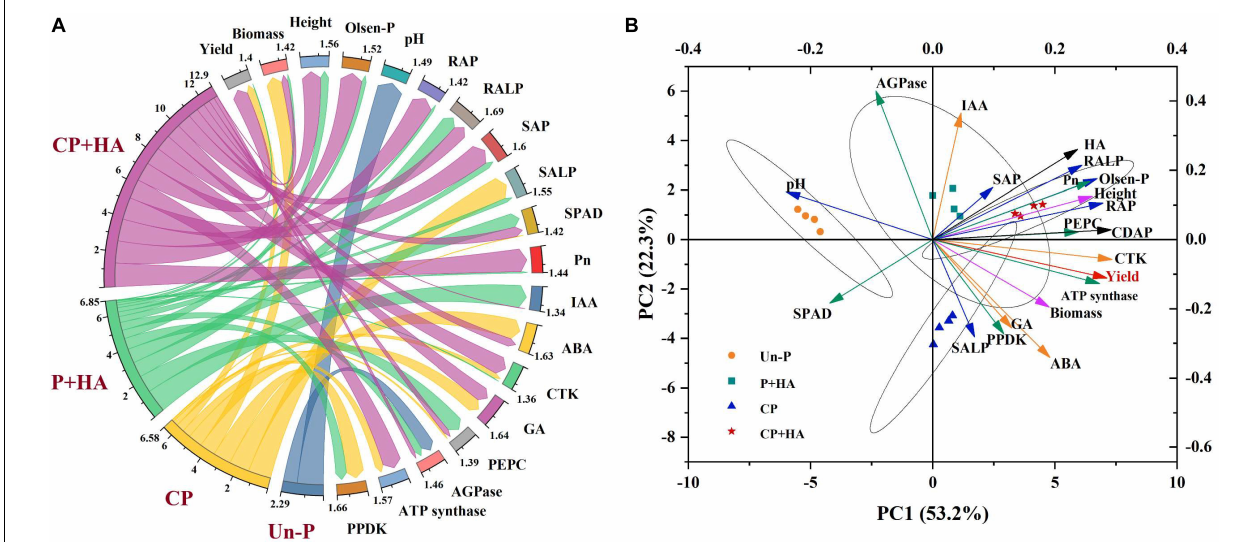
FIGURE 8 | (A) Chord diagram for showing the effects of the different treatments on these indices. This plot links these treatments via ribbons to their associated indexes. (B) Principal component analysis shows the relationship among grain yield, growth parameters, and soil nutrient. Height, plant height; SAP, soil acid phosphatase; SALP, soil alkaline phosphatase; RAP, root acid phosphatase; RALP, root alkaline phosphatase; Pn, photosynthetic rate; PEPC, Phosphoenolpyruvate carboxylase; AGPase, ADP-glucose pyrophosphorylase; PPDK, pyruvate phosphate dikinase; IAA, indole-3-acetic acid auxin; CTK, cytokinin; ABA, abscisic acid; GA, gibberellin. Un-P, uncoated DAP treatments (P 100% and P 80% treatments); CP, coated DAP treatments (CP 100% and CP 80% treatments); P + HA, uncoated DAP combined with HA treatments (P 100% + HA and P 80% +HA treatments); CP + HA, coated DAP combined with HA treatments (CP 100% + HA and CP 80% + HA treatments).